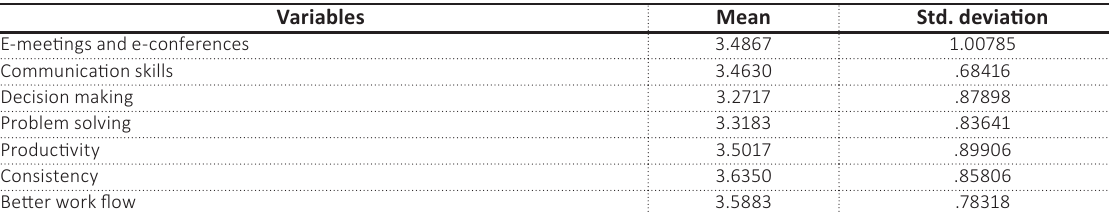
Table 6. Descriptive analysis of